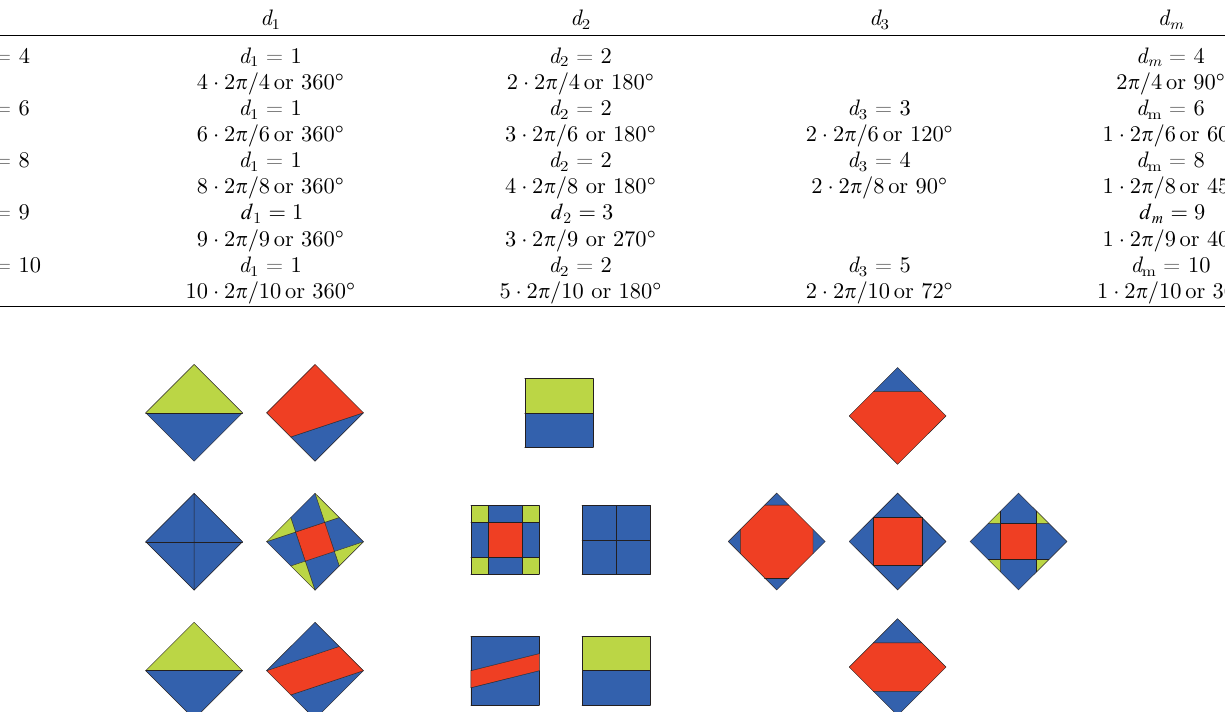
Table 5. Traces of d